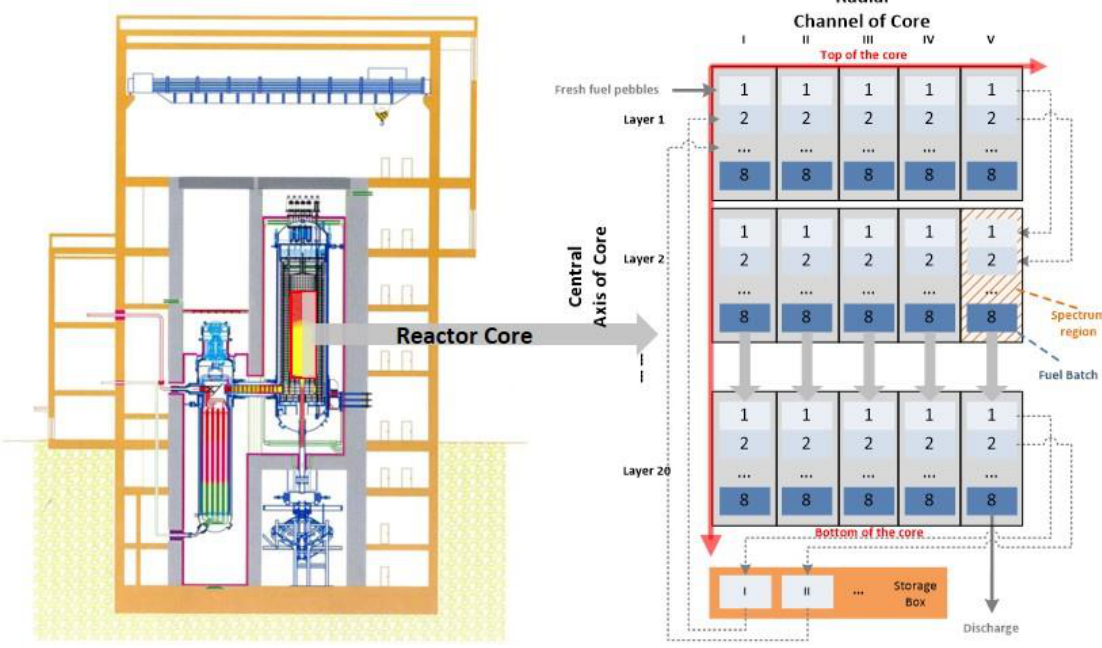
Figure 1. Cross-section view of HTR-PM reactor building [6] (left); V.S.O.P. burnup 2D model with adoption of eight times refueling scheme (right). The core is divided into five channels radially from the center to the outside, labelled from (cid:2) to (cid:3) . Each channel is subdivided axially into 20 regions from top of the core to bottom, with each representing individual spectrum region (orange shading). Each region contains eight fuel batches numbered by the times of fuel pebbles passing through the